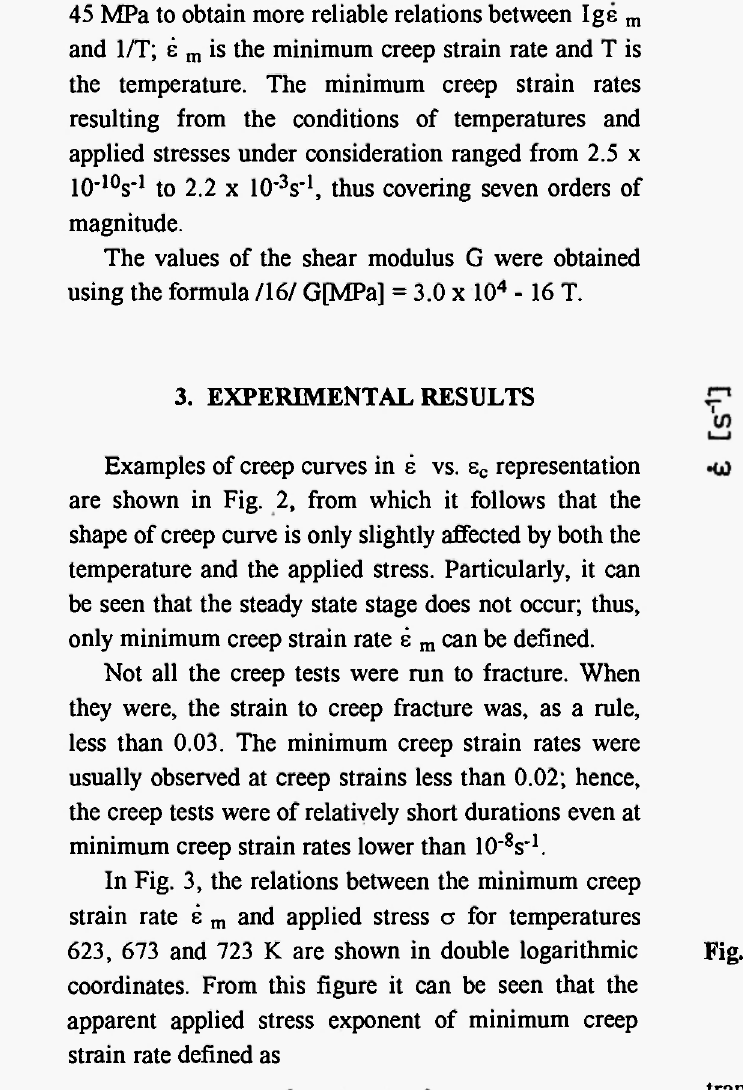
Fig. 2: Examples of creep curves in the creep strain rate έ - creep strain ες